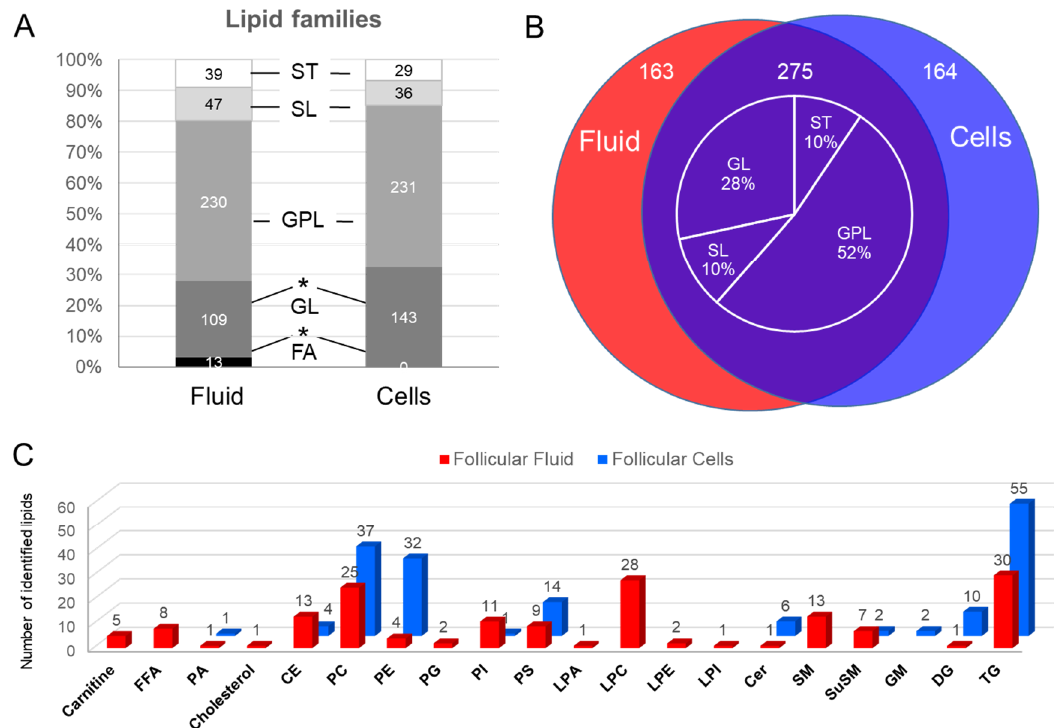
Figure 2. Identification of lipids in bovine 3–8 mm follicles by liquid chromatography coupled with high-resolution MS (LC/HRMS). ( A ) Family distribution of all of the lipids detected in follicular cells and fluid. * indicates significant difference ( p < 0.05, Chi-squared test). ( B ) Venn diagram presents all of the lipids identified in follicular fluid (FF, red circle) and follicular cells (blue circle). Distribution by families of 275 common lipid species is shown. ( C ) Distribution by classes of the lipids, detected either in follicular cells only (164 species, blue bars) or in FF (163 species, red bars). Number of identified lipids are indicated above the bars. ST—Sterols; SL—Sphingolipids;